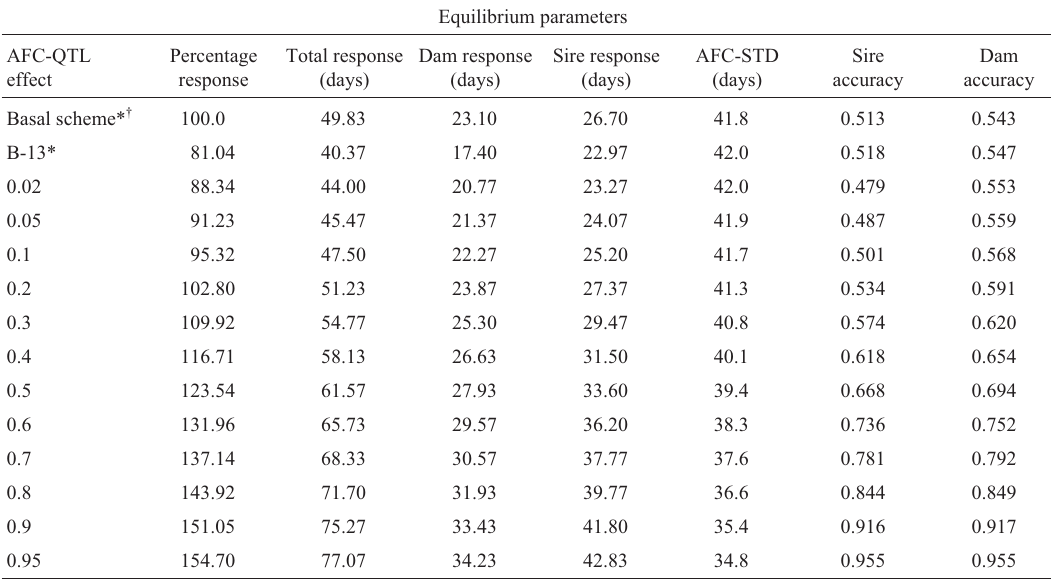
Table 6 - Scheme A3: Two-stage marker assisted selection of embryos at stage 1 and two-year old dams and sires at stage 2. Age at first calving (AFC) quantitative trait locus (QTL) total response as a percent of the basal scheme; total response and response due to selection of dams and sires in days; AFC breeding goal standard deviation (AFC-STD) and the accuracy for sires and dams for two-stage marker assisted selection with the AFC-QTL explaining 0.00 to 0.95 of the additive genetic variance.